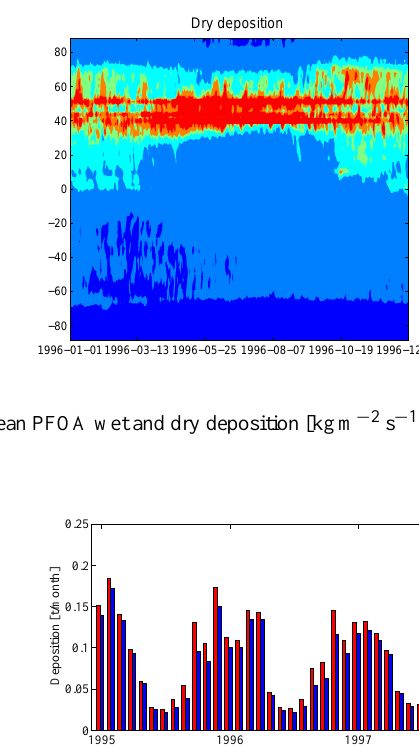
Fig. 8. Four-year time series of monthly sums of total (wet+dry) deposition [ t ] of PFOA to the Arctic.